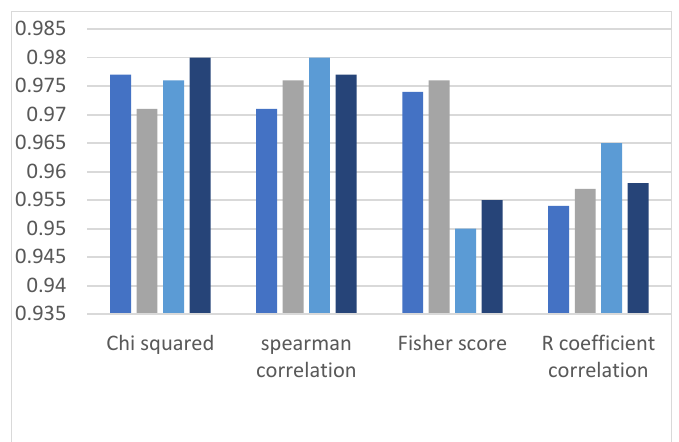
Figure 9. Precision using enhanced decision tree.